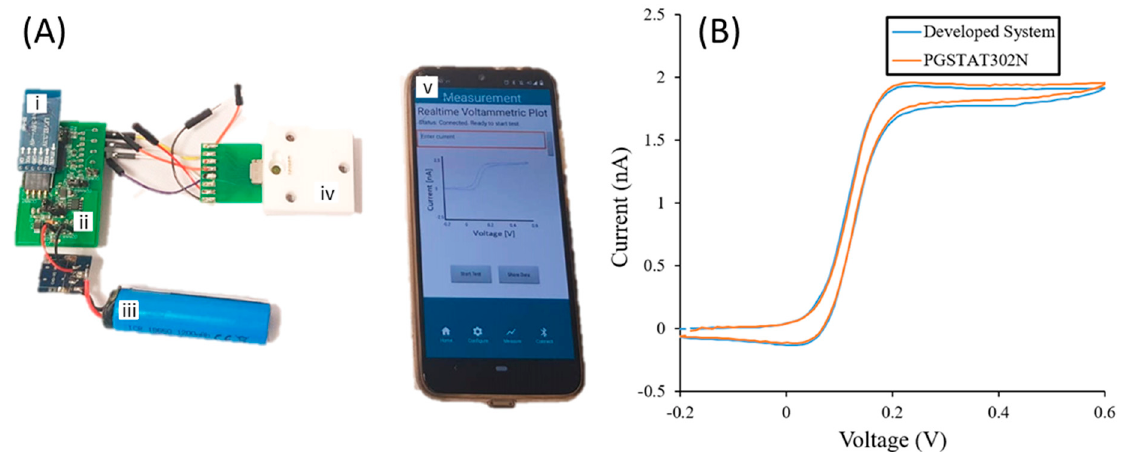
Figure 10. ( A ) Developed system interfacing to electrochemical sensor with (i) Bluetooth module, (ii) developed system printed circuit board, (iii) Lithium ion battery connected to charge protection circuit, (iv) electrochemical sensor holder and (v) Smartphone using developed application. ( B ) CVs at 200 mV/s for 1 mM FCA oxidation using both the developed system and the PGSTAT302N.